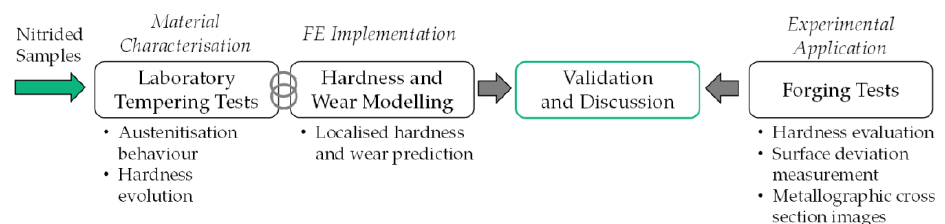
Figure 1. Research plan for the methodology of this study.